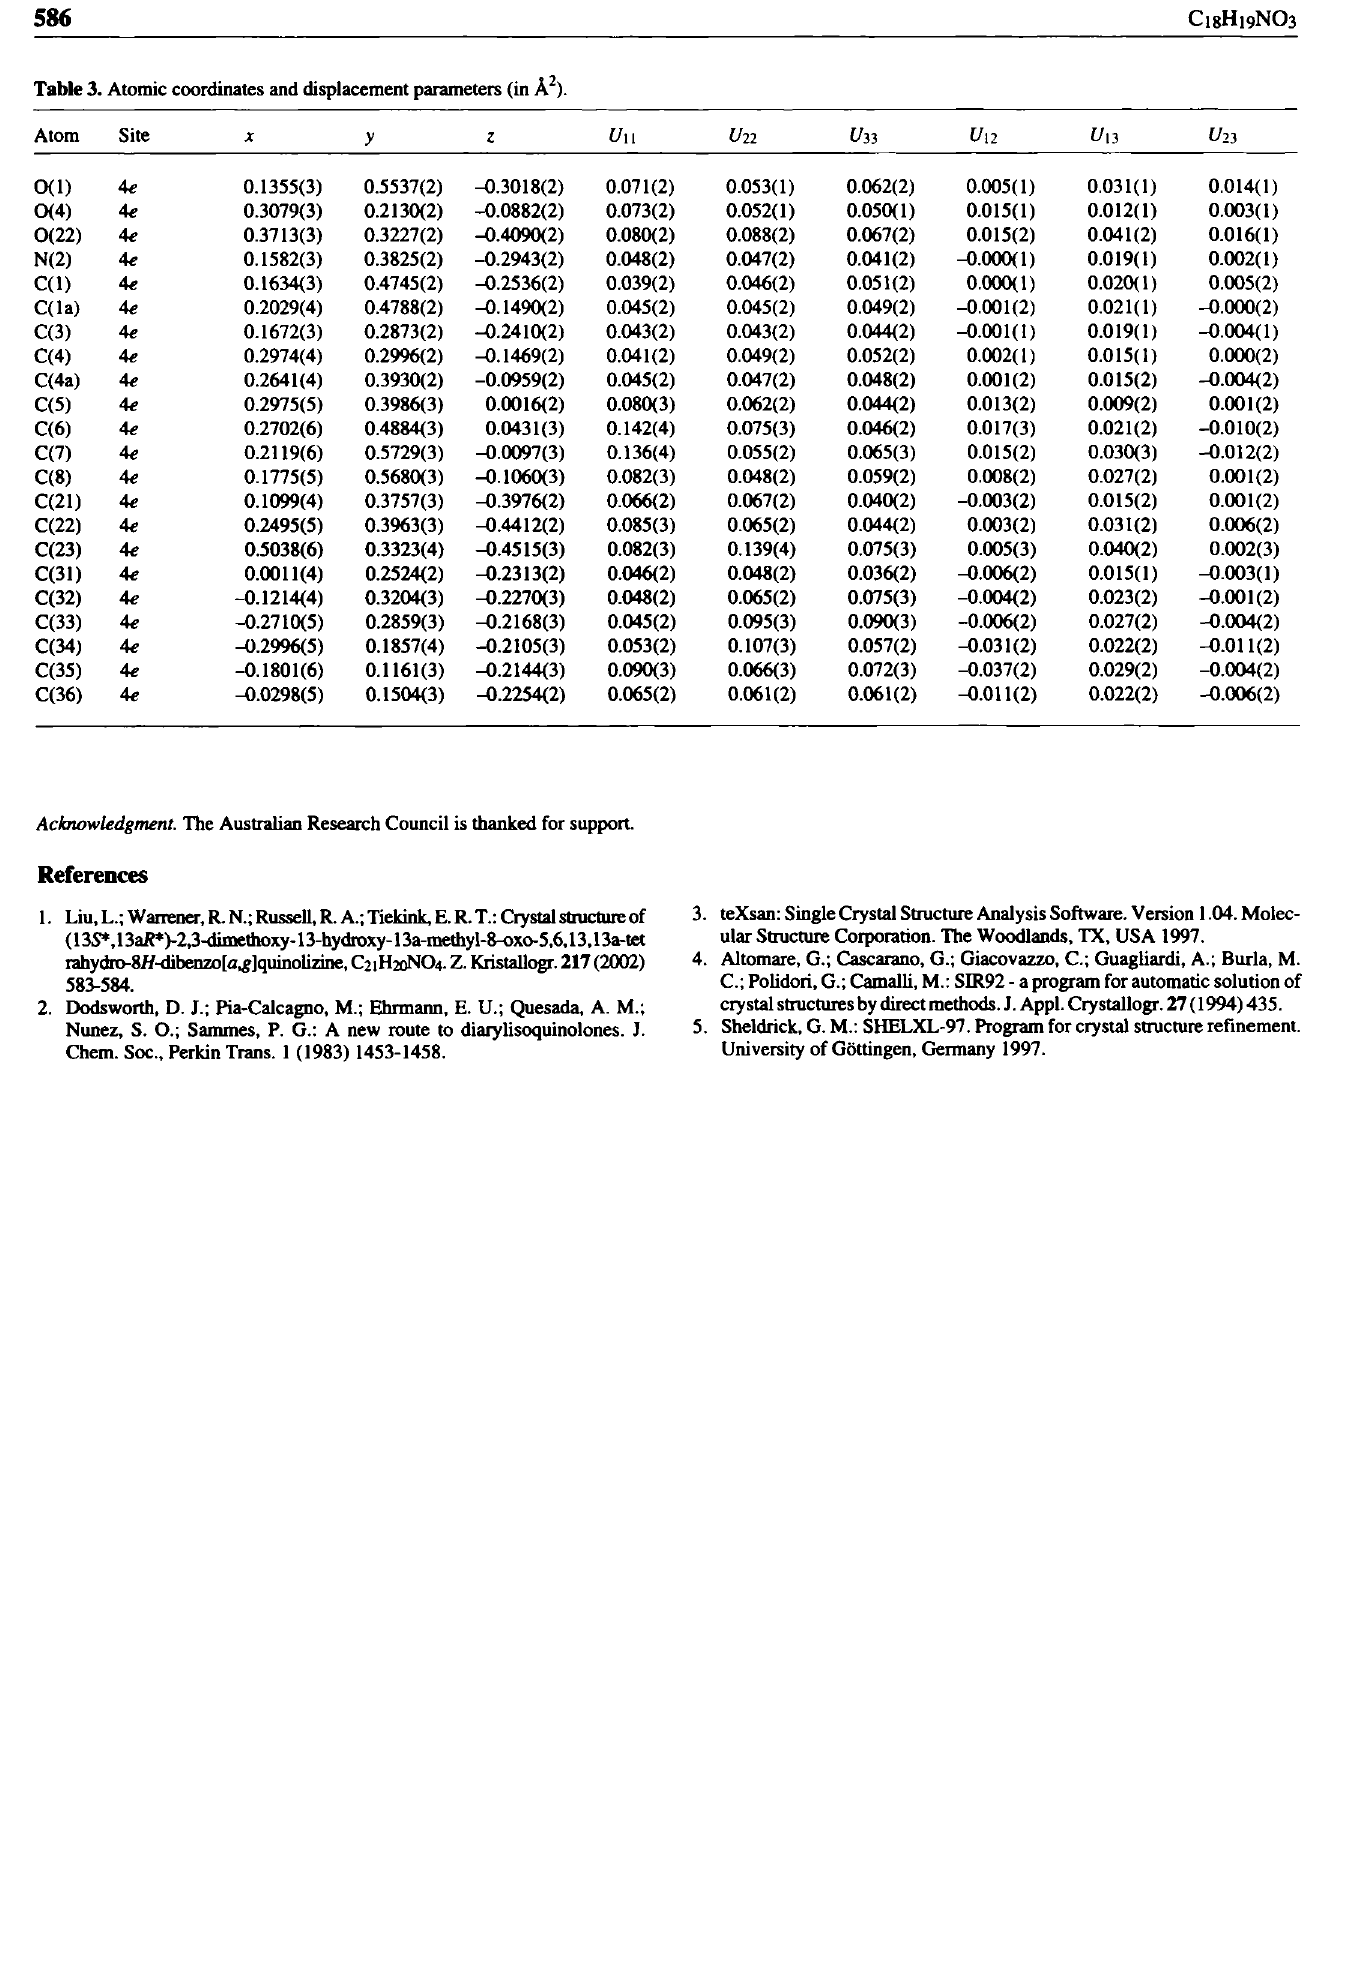
Table 3. Atomic coordinates and displacement parameters (in Â 2